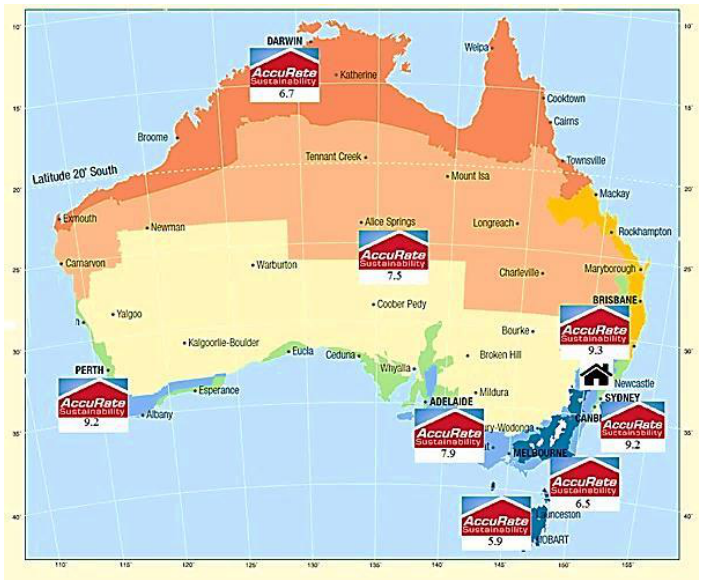
Fig. 4. AccuRate rating for different locations/climate zones in Australia